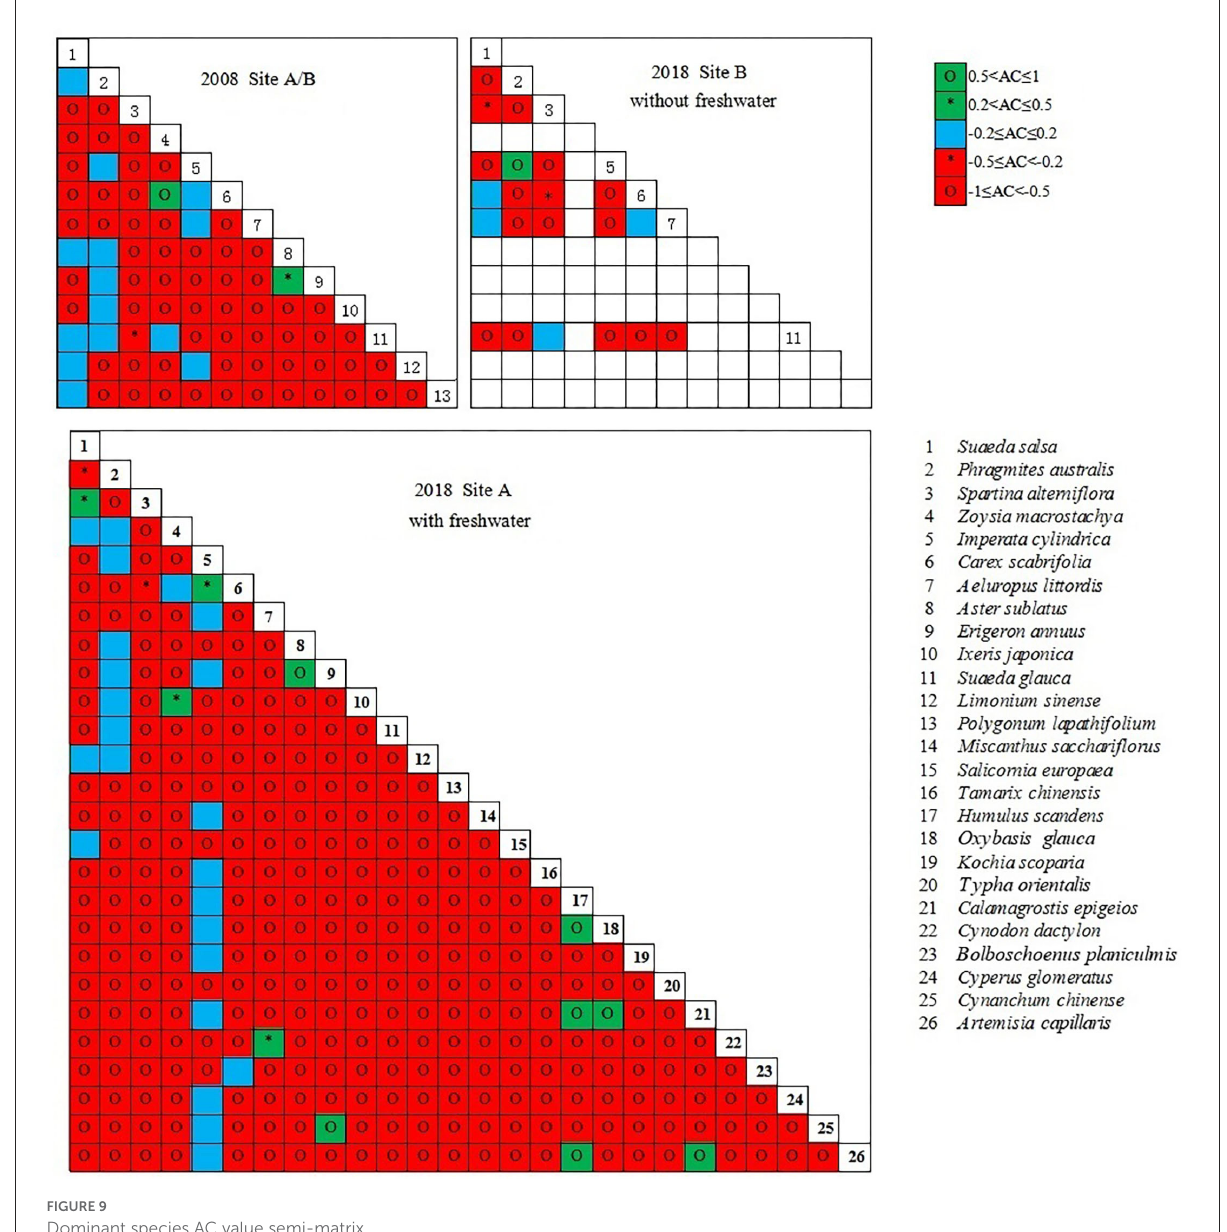
FIGURE9 Dominant species AC value semi-matrix.